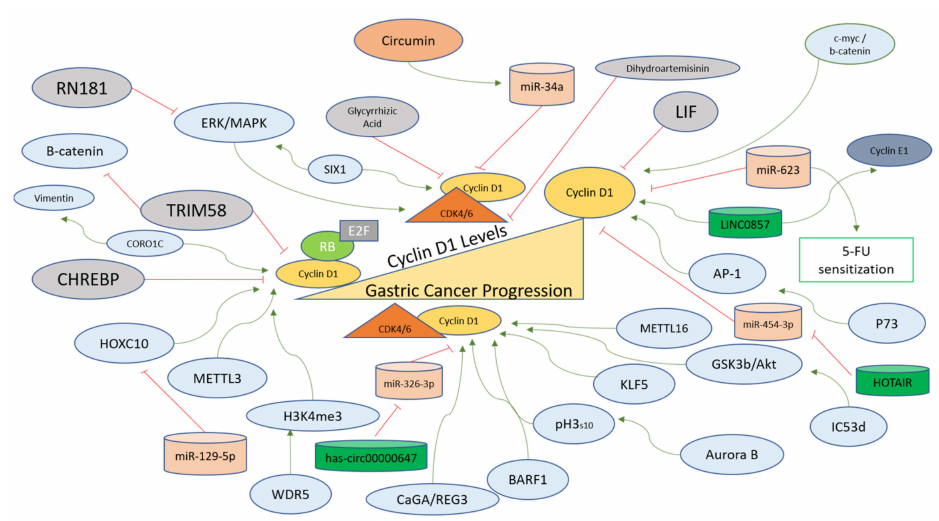
Figure 3. Cyclin D1 regulation in gastric cancer progression. Cyclin D1 levels are upregulated in gastric cancer and are affected positively (green arrows) for the oncogenic transformation of gastric cells via the action of upstream factors (blue). In normal gastric cells, the levels of Cyclin D1 remain tightly controlled via the negative regulators (red lines), which directly inhibit the transcription of the Cyclin D1 gene or inhibit the binding of Cyclin D1 with CDK4/6 directly or indirectly. The modes of action of these regulators are described in the main